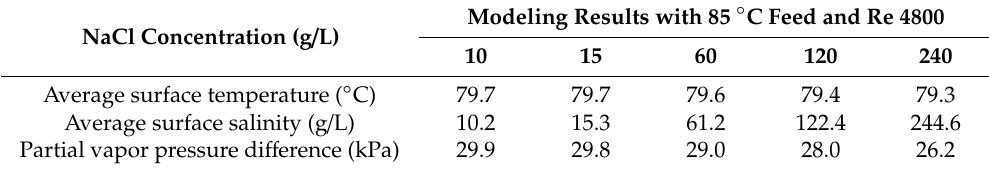
Table 3. Simulation results of parameters values with different Re.